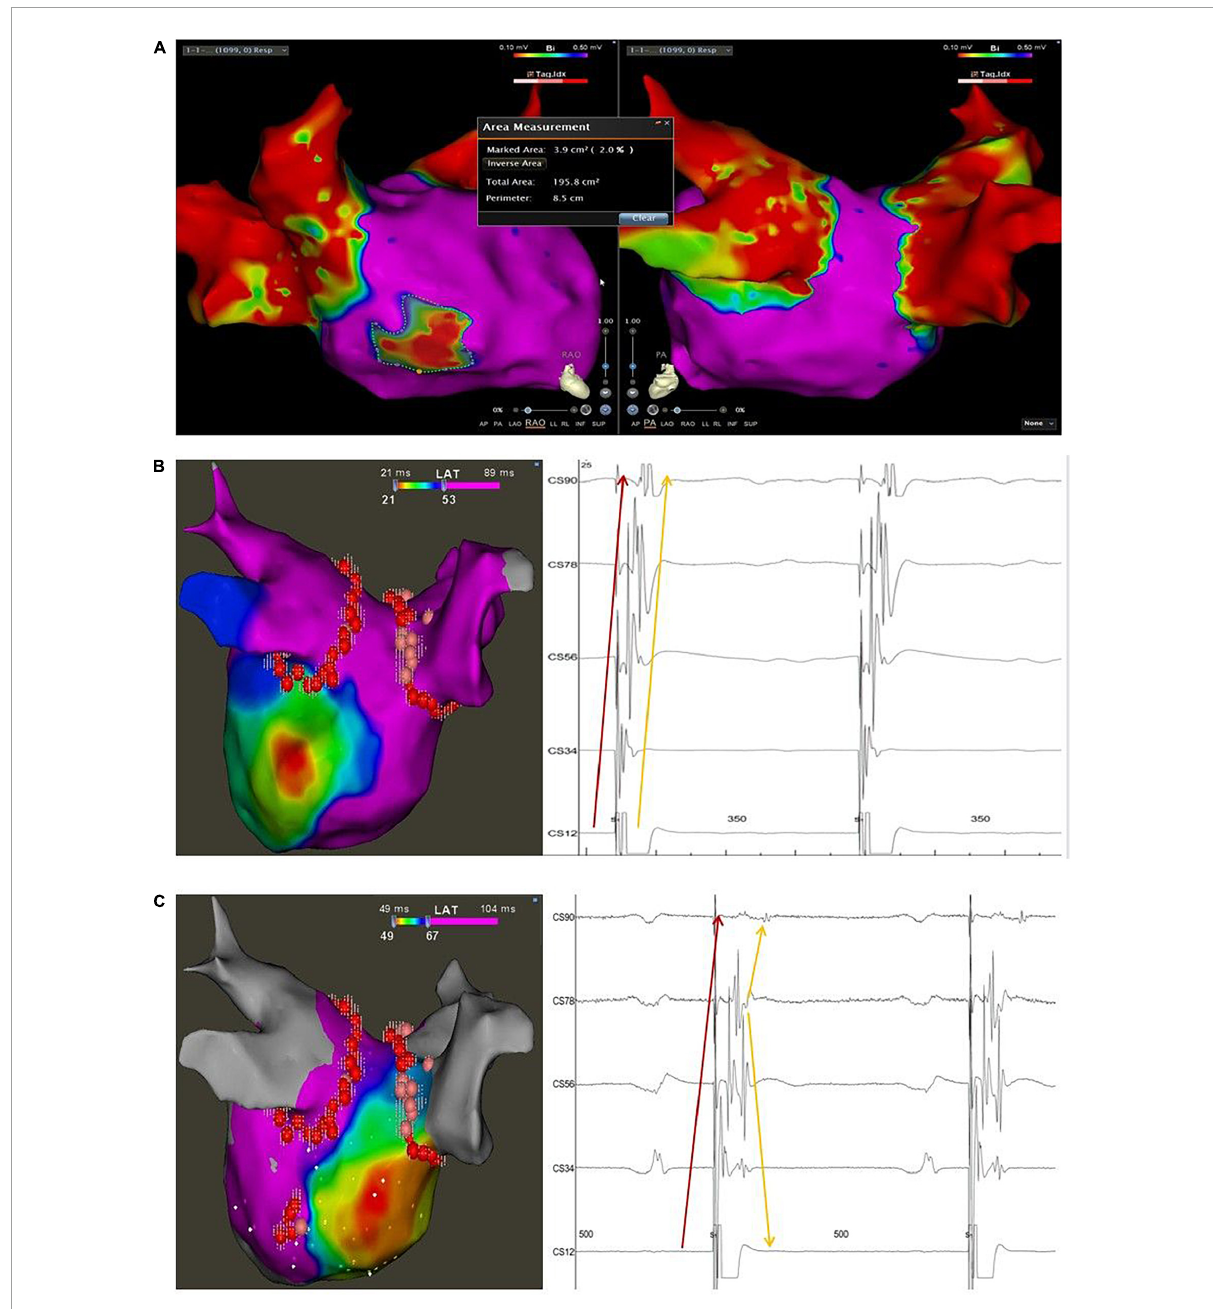
FIGURE1 Typical case of the study with LVA < 10% and disconnection of the CSD-LA musculature. (A) The bipolar map of the LA after CPVI and before elimination of the muscular connection between the distal CS and LA was obtained with high-density mapping using a PentaRay catheter during SR; the marked area represents the low voltage area of the LA by the Area Measurement Module of the Carto 3 system; the total area represents the whole area of the LA including the PVS. (B) , left panel: activation map of the LA during distal CS pacing before elimination of the muscular connection between the distal CS and LA. (B) , right panel: intracardiac local electrograms recorded on the decapolar catheter during distal CS pacing before ablation at the connection between the distal CS and LA, presenting two discrete but parallel activated sequences from distant CS to proximity; the sharp electrograms pointed by the red arrow indicate the near field activation of the CS musculature, and the blunt electrograms pointed by the yellow arrow indicate the far-field activation of the LA. (C) , left panel: activation map of the LA during distal CS pacing after elimination of the muscular connection between the distal CS and LA; (C) , right panel: intracardiac local electrograms recorded on the decapolar catheter during distal CS pacing after blocking the connection between the distal CS and LA, presenting two discrete but intersectant activated sequences recorded on the polar CS; The sharp electrograms pointed by the red arrow indicate the near field activation of the CS musculature, which shows an activation sequence from distal to proximal; the blunt electrograms pointed by the yellow arrow indicate the far-field activation of the LA, which shows an activation sequence from proximal to distal. The pivot activation sequence recorded at the proximal polar CS (CS78) suggests the change of the earliest activation site of the LA from the posterior-lateral wall to the